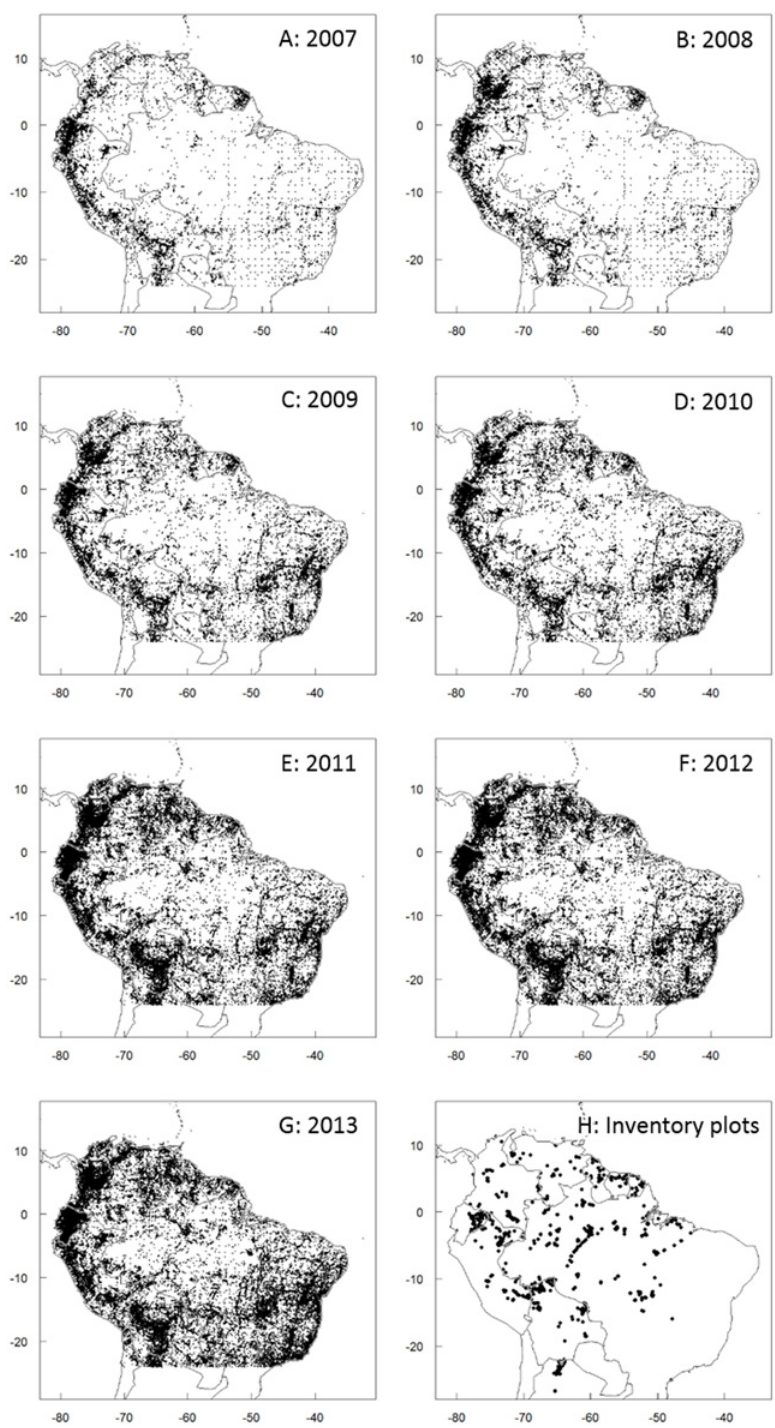
Fig 1. Locations of occurrence records and census plots in tropical South America. Maps showing the location of plant occurrence records available through GBIF each year from 2007 to 2013 (Panels A-G, respectively) and the location of the networked vegetation census plots included in the analyses (Panel H).